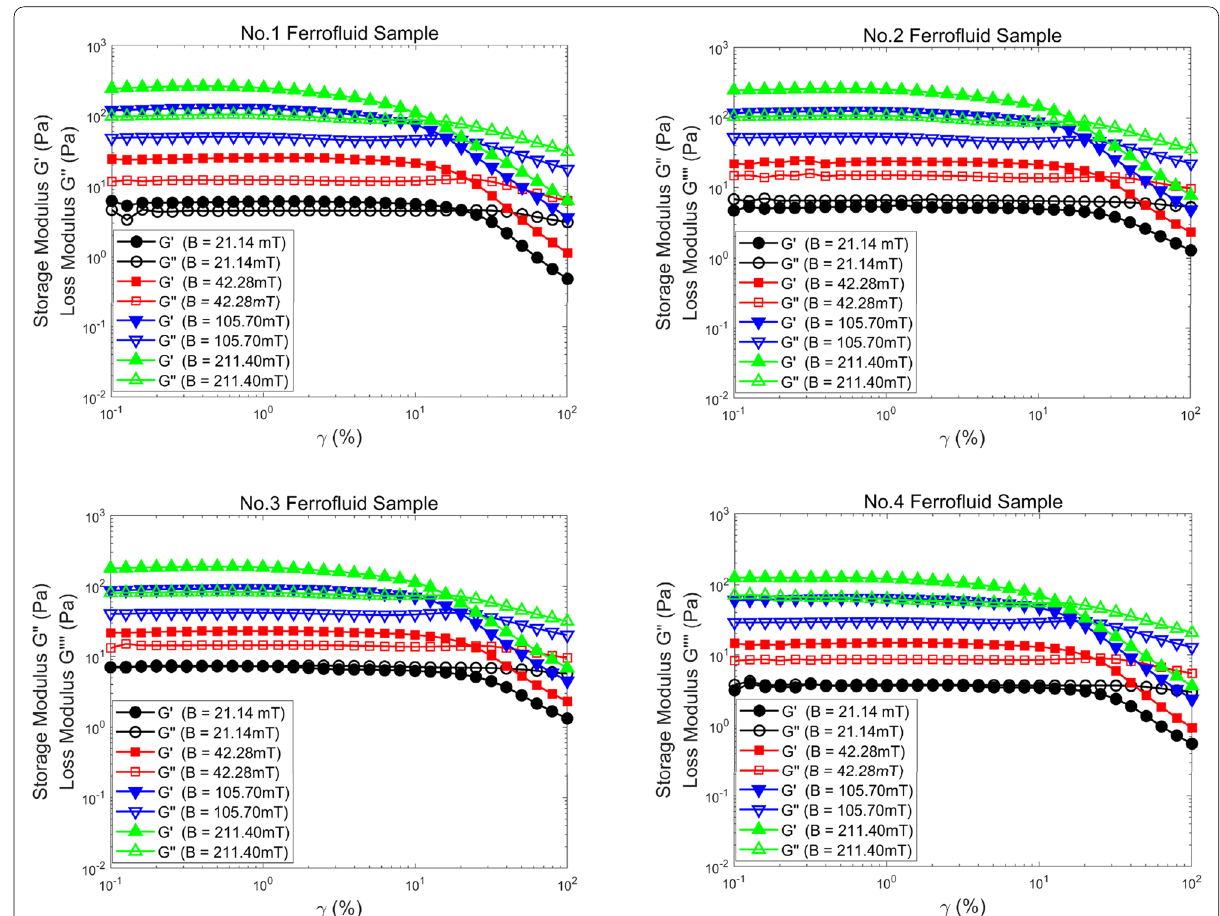
Figure 7 Viscoelastic properties of ferrofluid samples under different external magnetic